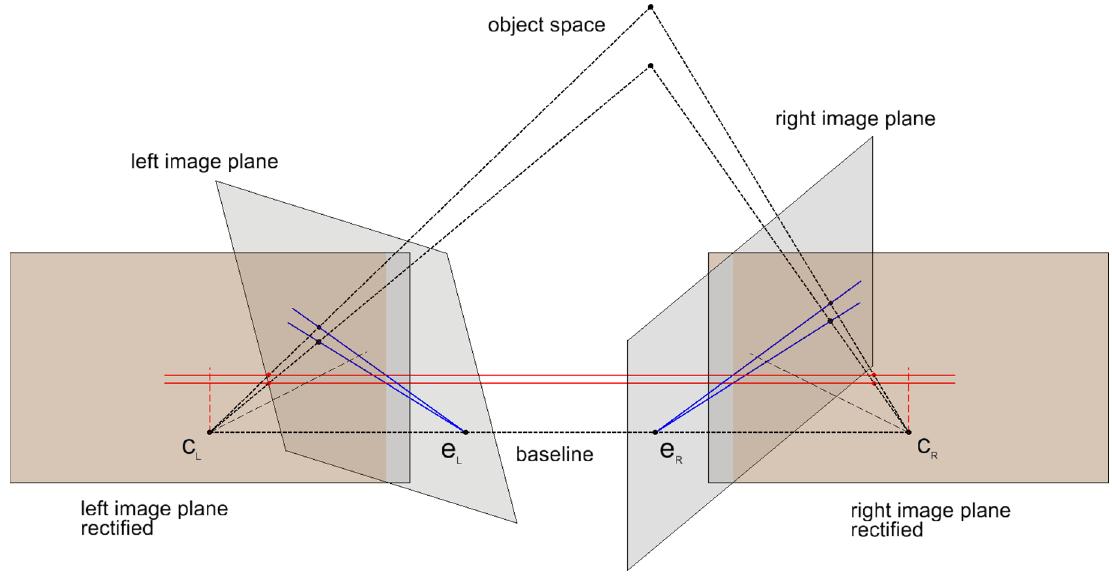
Figure 4. Epipolar geometry—initial image planes (gray) and stereo rectified images planes (orange).